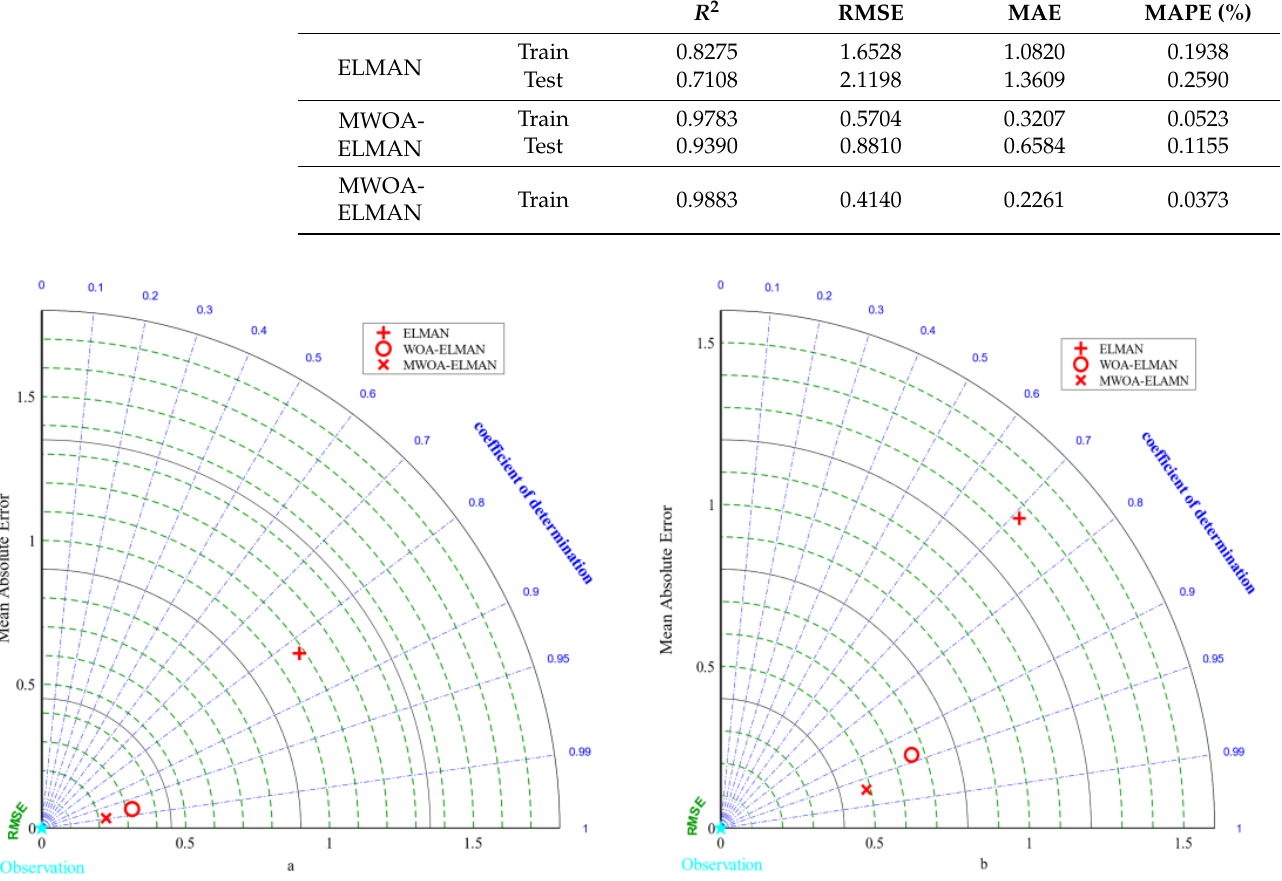
Figure 10. Taylor diagrams for the Training ( a ) and Testing ( b ) sets of the three ELMAN models. Table 7. Average of evaluation indicators for three ELMAN models.